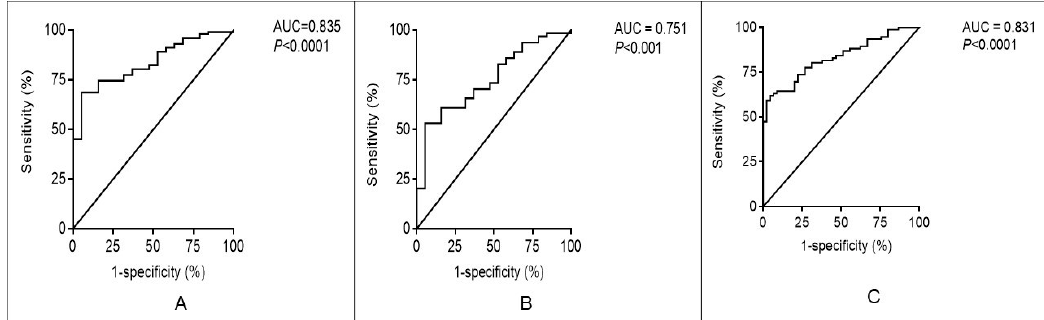
Figure 4. The receiver operating characteristic curve analysis to determine the predictive value of breath ammonia concentration to distinguish between different chronic kidney disease groups. ( A ) The receiver operating characteristic curve analysis for breath ammonia to distinguish between CKD stage 1 and other CKD stages (2–5). ( B ) The ROC curve analysis for breath ammonia to distinguish between CKD stage 1 patients and CKD stage 2 and 3 patients. ( C ) The ROC curve analysis for breath ammonia to distinguish patients between patients with eGFR 60 mL/min/1.73 m 2 and patients with eGFR < 60 mL/min/1.73 m 2 . AUC: area under curve.